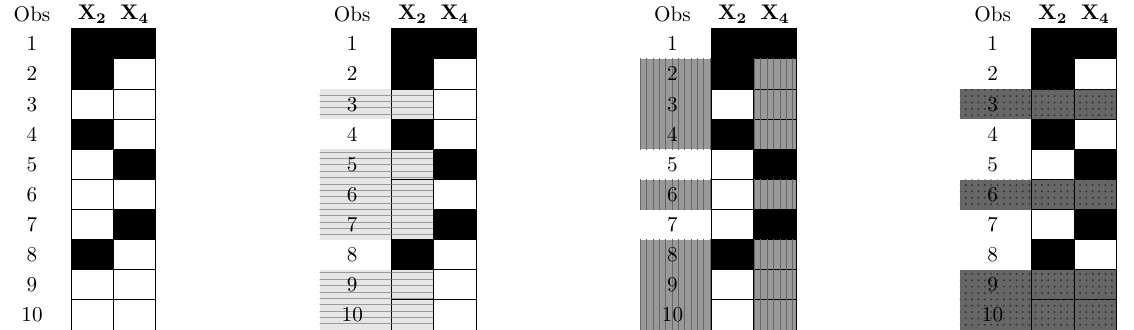
Figure 2. Observations associated with a sub-model, based on the observed values, where each shading signifies a different sub-model. ( a ) The data for the selected model containing the variables X 2 and X 4 . Black—missing data; white—observed data. ( b ) Light grey—the observed data for the sub-model containing just the variable X 2 . ( c ) Grey—the observed data for the sub-model containing just the variable X 4 . ( d ) Dark grey—the observed data for the sub-model containing both variables X 2 and X 4